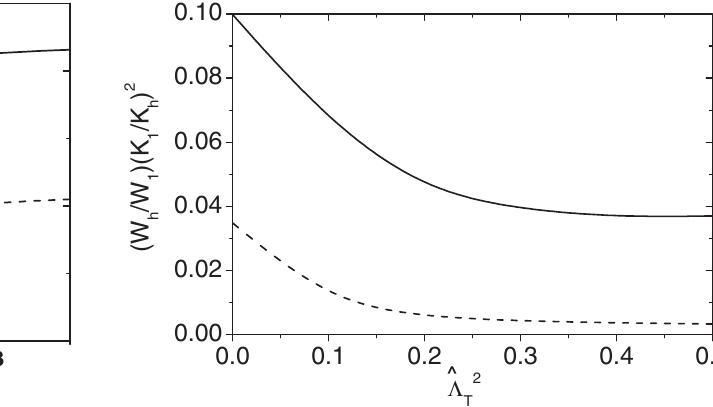
FIG. 5. Normalized power ratio at saturation (cid:1) W (cid:2) 2 for the 3rd (solid line) and 5th (dashed line) harmonic (cid:1) K =K h 1 as a function of energy spread parameter ^ (cid:4) 2 opeartes at saturation.